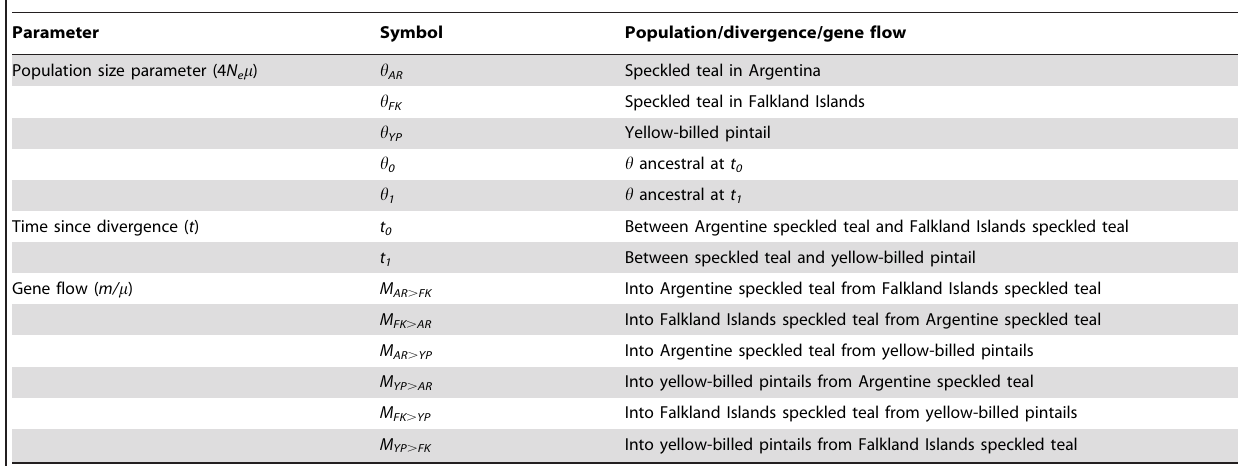
Table 2. Estimated parameters in the three-population IMa2